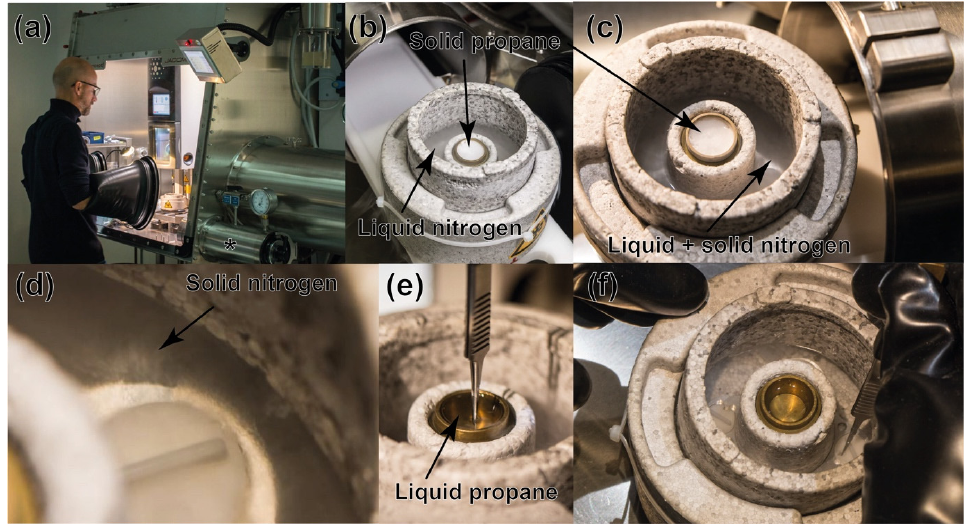
Figure 2. Cryo-EM grid preparation under anaerobic conditions. ( a ) View of the glovebox with the Vitrobot system inside. The symbol * shows the small airlock used to introduce the cryo-EM grids’ freezing Dewar. ( b ) View of the Dewar with its liquid nitrogen-filled pot and cup with solid pro- pane, before its introduction to the airlock; and ( c ) treatment under vacuum inside the airlock causes the solidification of the nitrogen bath. ( d ) Close view of the pot with solid nitrogen (black arrow).